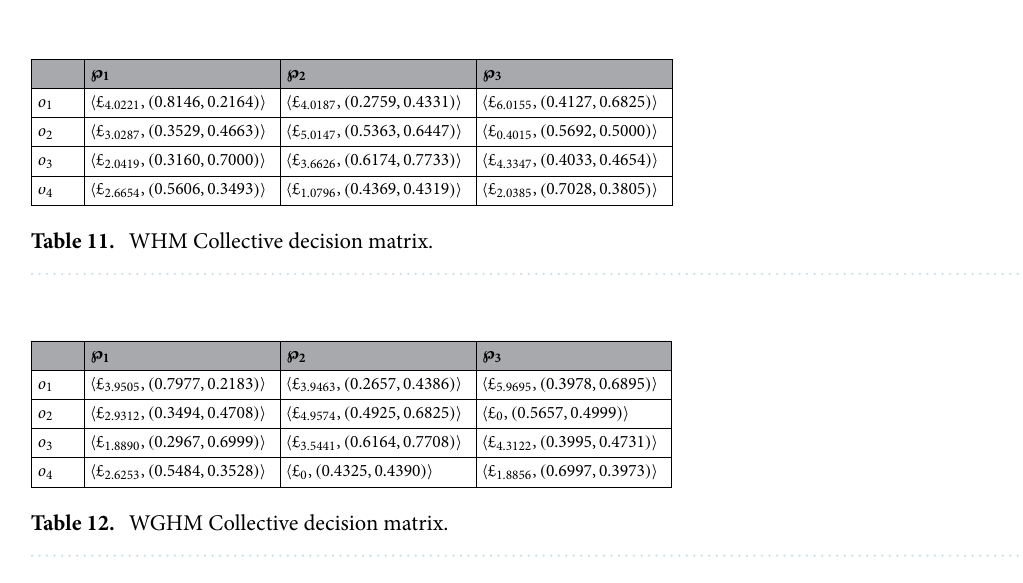
Figure 6. Ranking results when ̟ 1 = 0.35 , ̟ 2 = 0.35 and ̟ 3 = 0.3 .